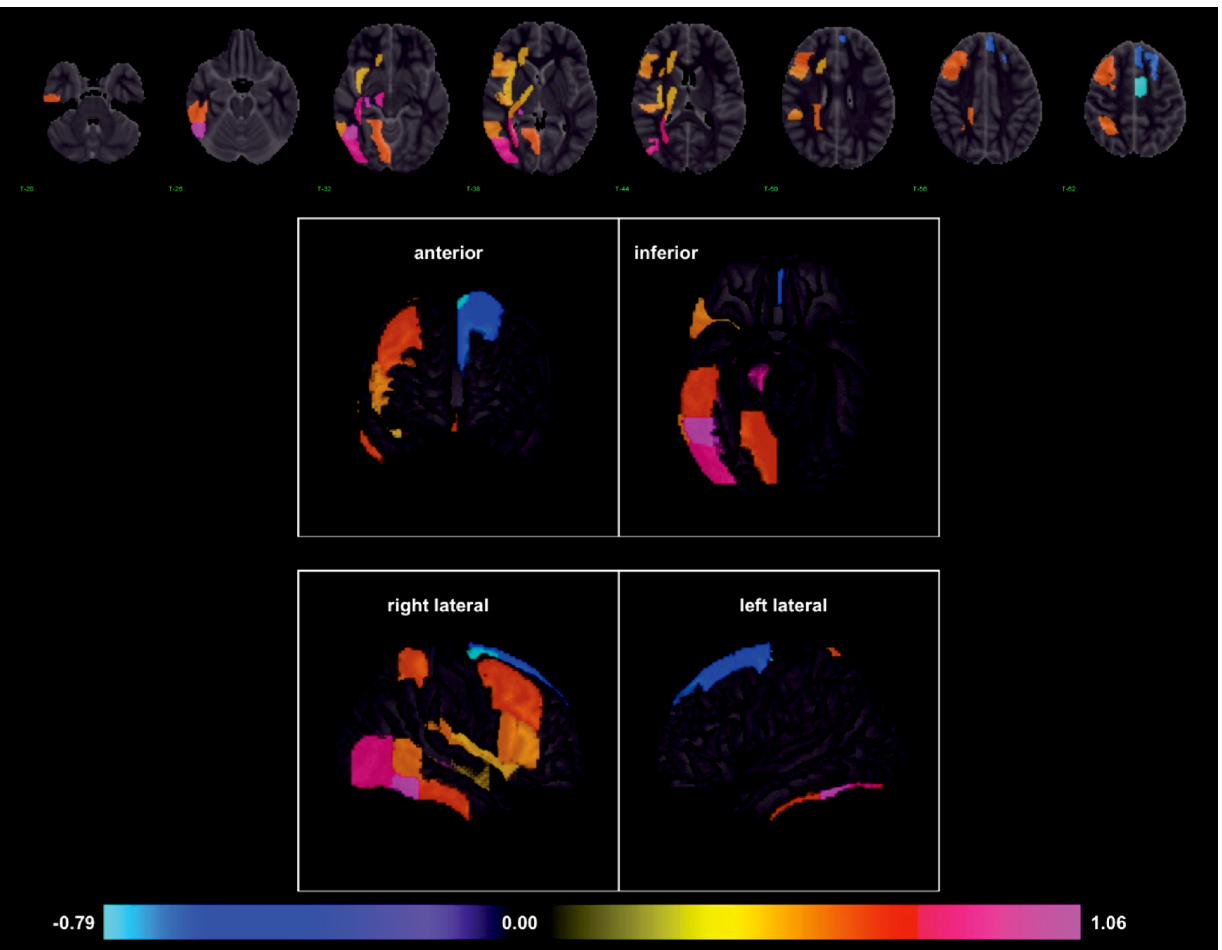
Figure 2. Infarcted brain regions with significant odds of developing HAP in stroke patients, expressed as log-OR (range 2 0.79 to 1.07; p , 0.02). Displayed as axial and cortical 3-dimensional representations.